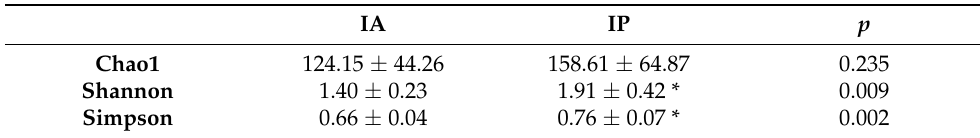
Table 1. Alpha diversity indices of bacterial communities in anterior (IA) and posterior (IP) intestinal sections of wild C. labrosus .